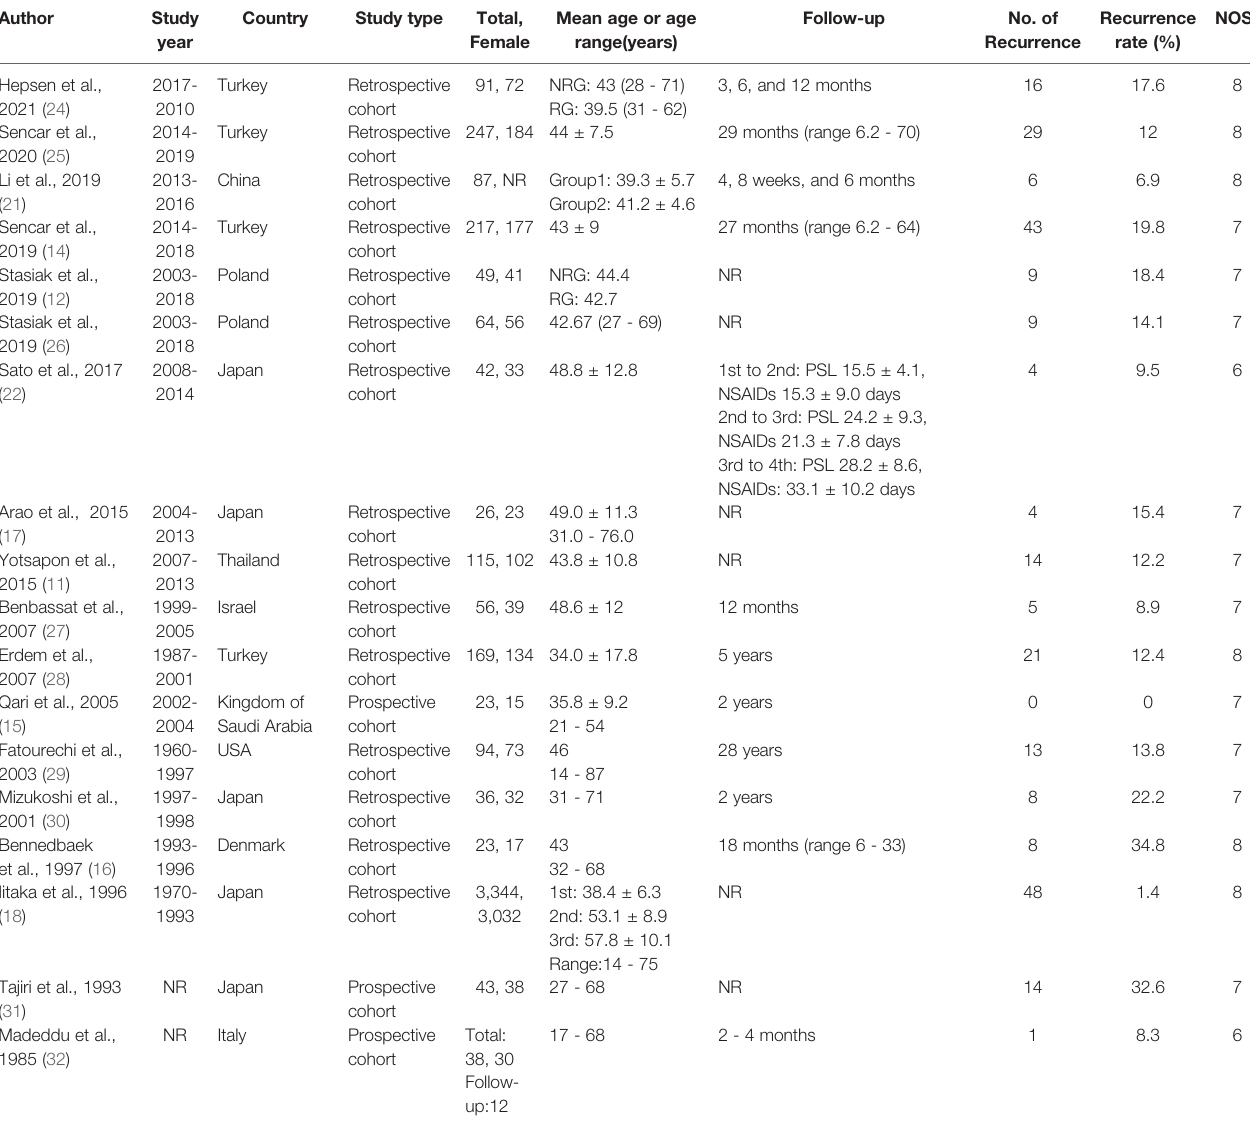
TABLE 1 | Characteristics and recurrence of included